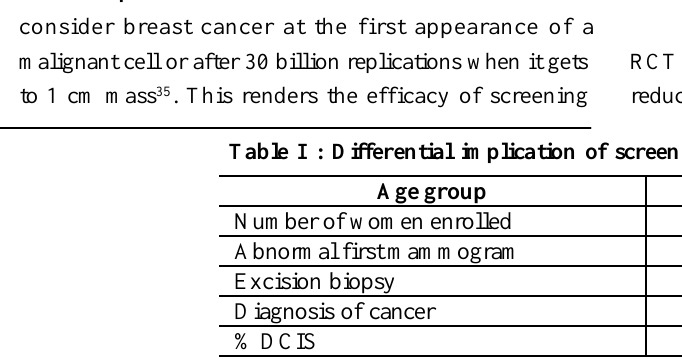
KEY POINT 4b : Screening implications are different